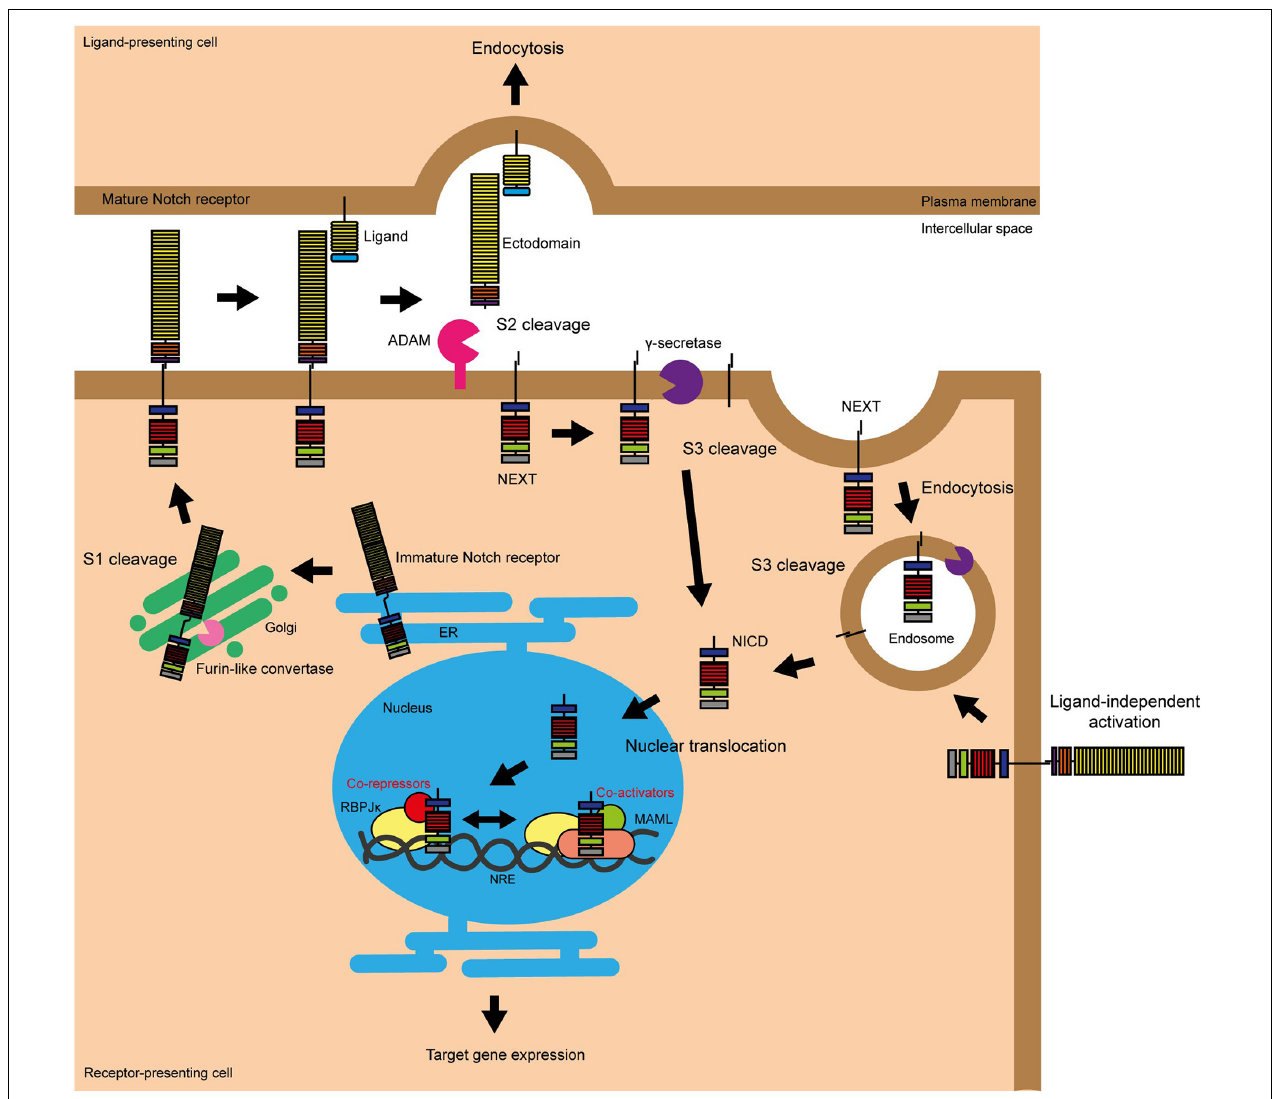
FIGURE 1 | Activation of Notch signalling. The Notch pathway can be activated in two ways, either by interacting with a ligand on an adjacent cell or following endocytosis driven by Deltex. S1 cleavage occurs in the Golgi and mediates the production of the mature Notch heterodimer which is presented on the surface of the cell. Ligand binding stimulates S2 cleavage, which causes the release of the Notch ectodomain and subsequent endocytosis by the ligand-presenting cell. S2 cleavage provides the substrate for γ -secretase, which carries out the final S3 cleavage and releases NICD into the cytoplasm where it can translocate into the nucleus to activate target gene transcription (Fortini, 2009; Aster et al., 2017). The endocytosis of the Notch protein to the multivesicular body driven by Deltex also provides a substrate for γ -secretase and thus target gene transcription (Steinbuck and Winandy,